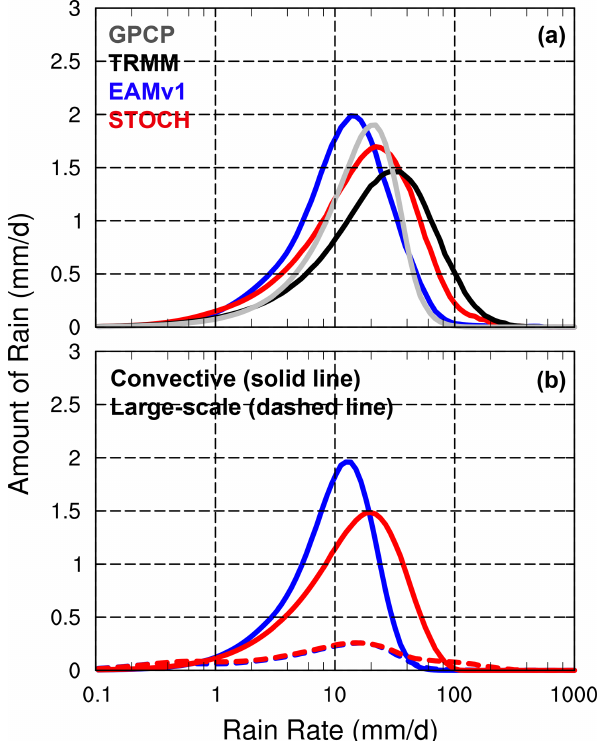
Figure 6. Annual mean rainfall amount distributions of (a) total precipitation (solid line) over the tropics (20 ◦ S, 20 ◦ N) for GPCP 1DD (gray), TRMM (black), EAMv1 (blue) and STOCH (red). In- dividual distributions of (b) convective (solid line) and large-scale (dashed line) precipitation in EAMv1 (blue) and STOCH (red) are also shown. The rainfall intensity on the x axis is on a logarithmic scale with bin intervals of (cid:49) ln (R) = (cid:49)R/R = 0 . 1.